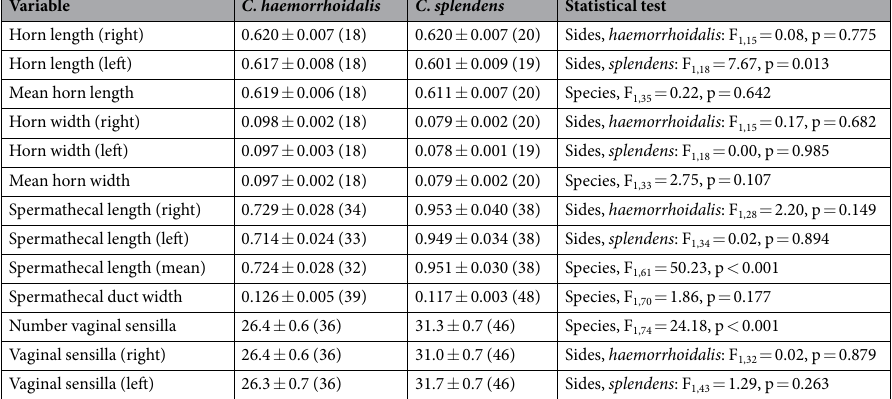
Table 1. Biometry of male and female genitalia in C. haemorrhoidalis and C. splendens from Central Italy. Values are mean ± SE (N) (mm, except for number of sensilla). Statistical tests are the results of ANOVAs comparing sides for the same species, with individual as a random factor, or comparing species. In all cases, wing length was entered as a covariate. Variables were Box-Cox or log transformed if needed, but the untransformed data are presented in the table.